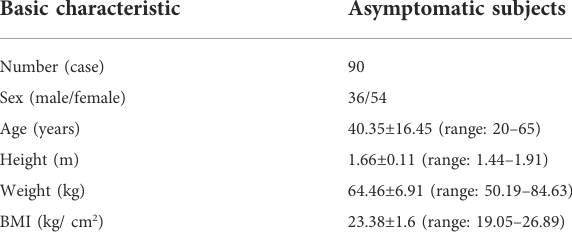
TABLE 1 The basic characteristics of the